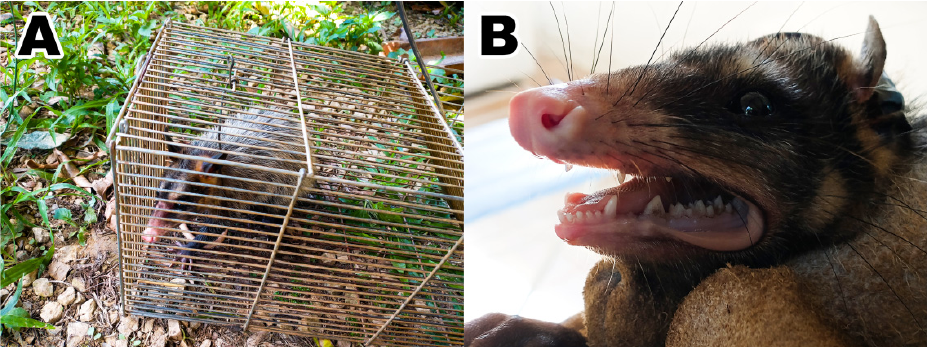
Figure 2. A black-eared opossum ( Didelphis aurita ), male, adult. ( A ) Inside the Tomahawk trap. ( B ) During physical restraint.